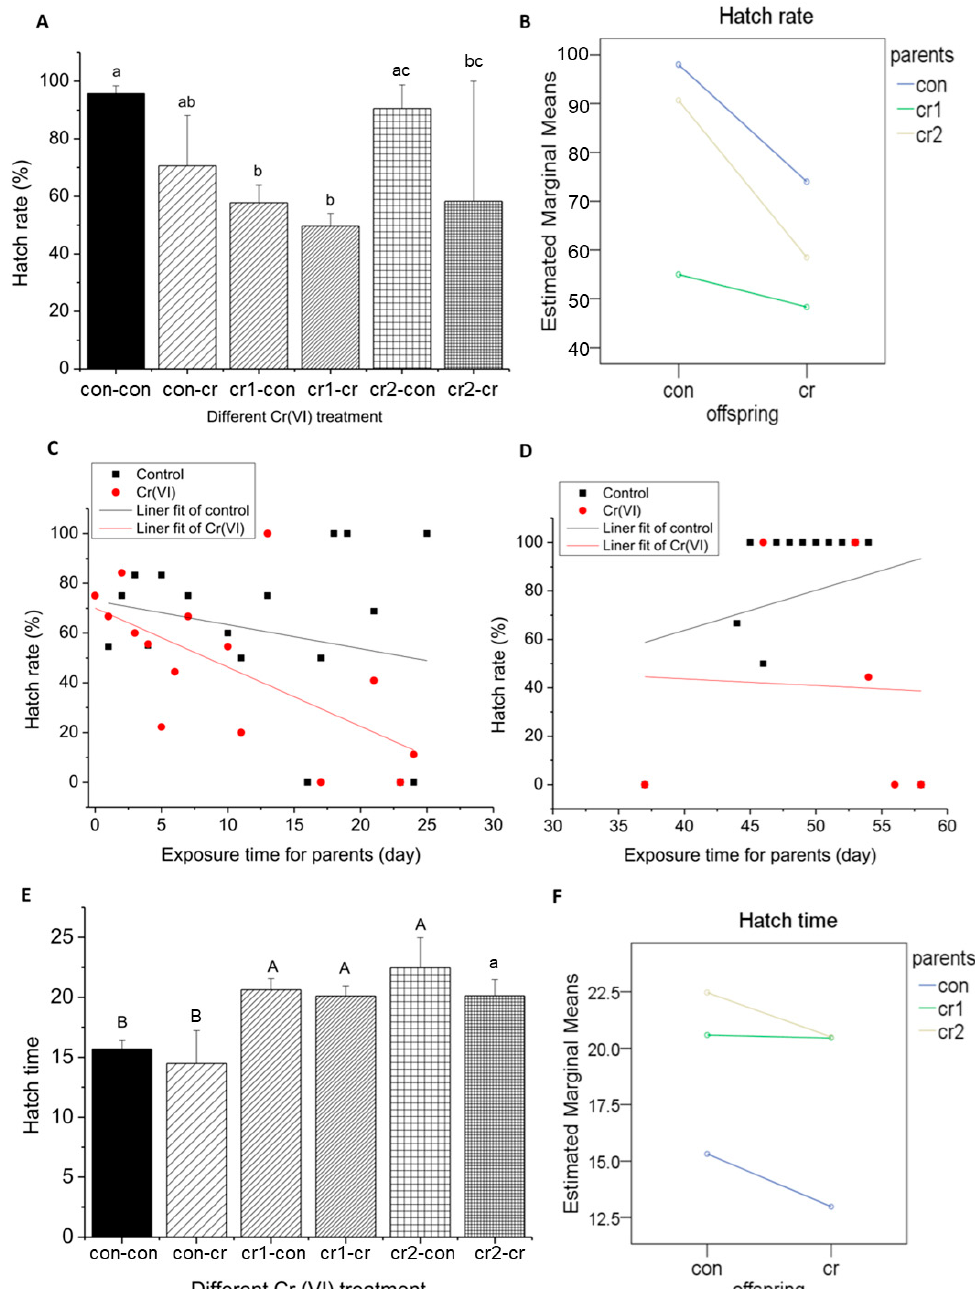
Figure 8. The hatch situation after long-term Cr(VI) exposure in marine medaka offspring. ( A – D ) hatch rate; ( A ) the hatch rate of offspring under different Cr(VI) treatment, different lower case means the significant differences among different treatment ( p ≤ 0.05); ( B ) the interaction of parent and offspring Cr(VI) treatment for hatch rate ( p = 0.030); ( C , D ) daily hatch rate under different offspring Cr(VI) exposure after parental Cr(VI) exposure, X axis represents parental treatment, and Y axis represents daily hatch rate, the blank line represents offspring in control environment, the red line represents offspring in Cr(VI) environment; ( C ) parental Cr(VI) exposure for first month, the function relationships between exposure time and death rate were y = − 0.96x + 72.98, R 2 = − 0.006 (untreated offspring) and y = − 2.38x + 70.07, R 2 = 0.352 (treated offspring); ( D ) parental Cr(VI) exposure for second month, the function relationship between exposure time and hatch rate were y = 1.64903x − 2.2166, R 2 = − 0.003403 (untreated offspring) and y = − 0.27718x + 54.78429, R 2 = − 0.24754 (treated offspring); ( E , F ), hatch time; ( E ) the hatch time of offspring under different Cr(VI) treatment, different letter means the significant differences among different treatment (upper letter: p ≤ 0.01, lower letter: p ≤ 0.05); F, the interaction of parent and offspring Cr(VI) treatment for hatch time( p = 0.001). The number of biological samples used for each group is as follow: con-con ( N = 315), con-cr ( N = 55), cr1-con ( N = 120), cr1-cr ( N = 141), cr2-con ( N = 37), cr2-cr ( N =